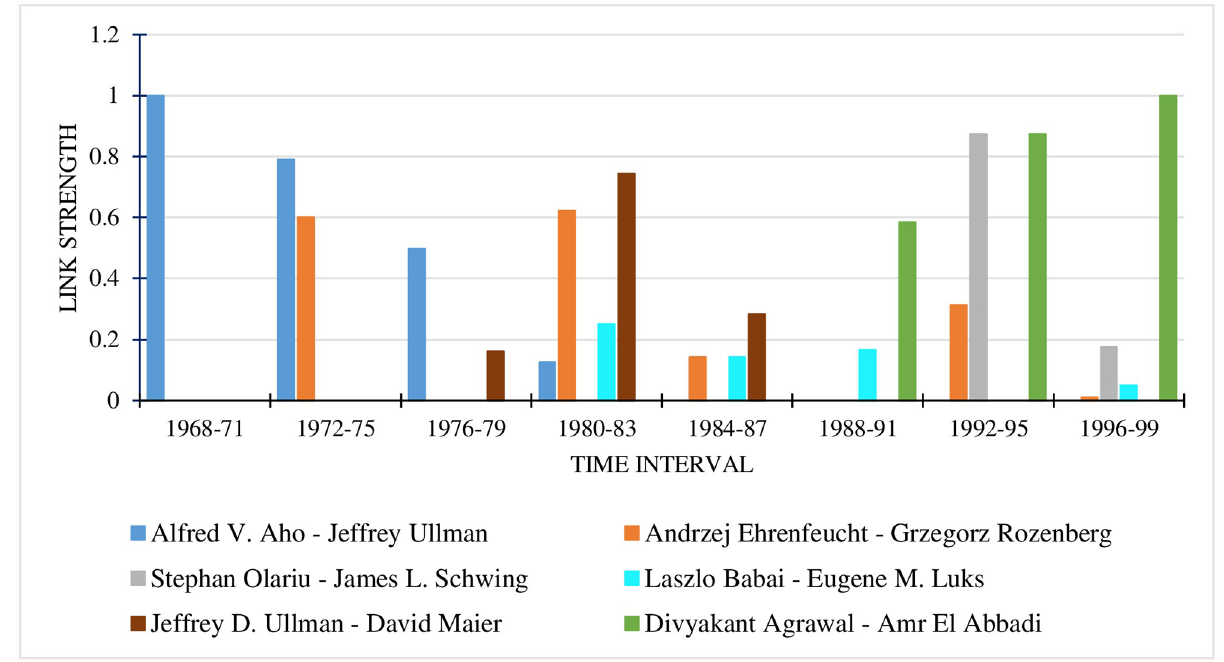
Fig 4. Link strengths between authors for 4-year time